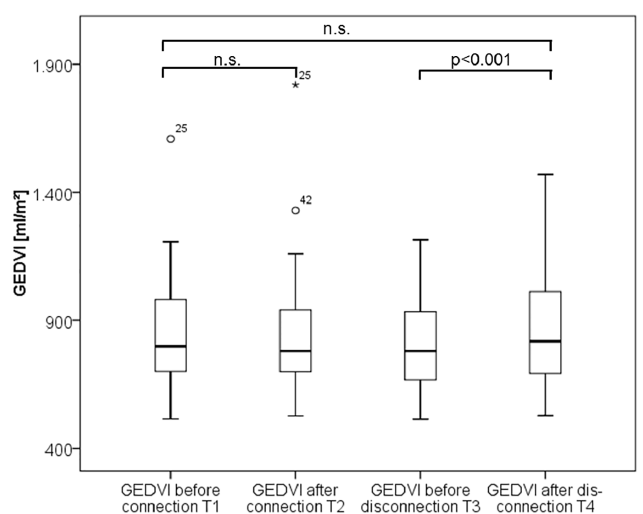
Fig 4. Boxplots comparing global end-diastolic volume index (GEDVI) values over